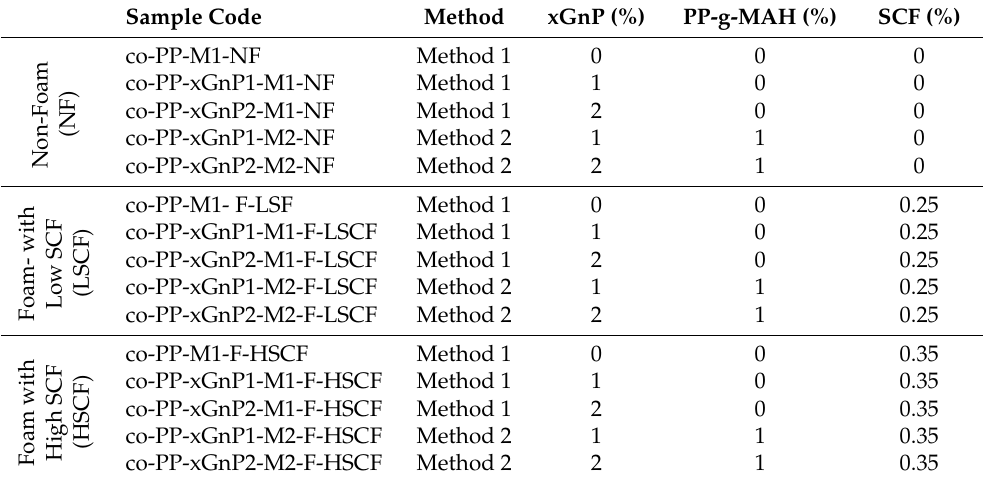
Table 3. Prepared foam injection-molded samples via Method 1 (M1) and Method 2